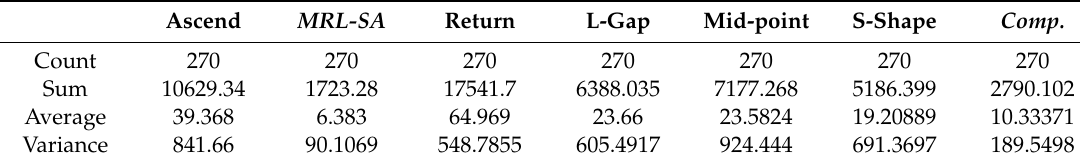
Table 7. Statistical analysis.